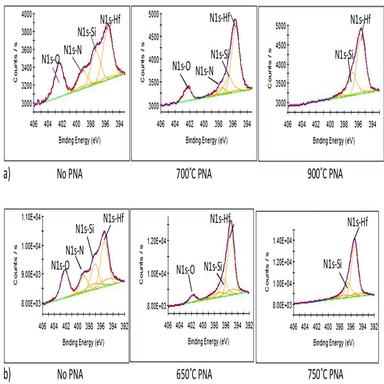
IL: 2a. thermal; N-O disappears between 700C and 900C; 2b. Chem-Ox; N-O disappears between 650C and 750C.